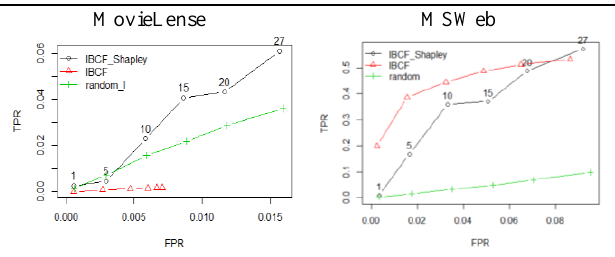
Figure 8. ROC curve of three models